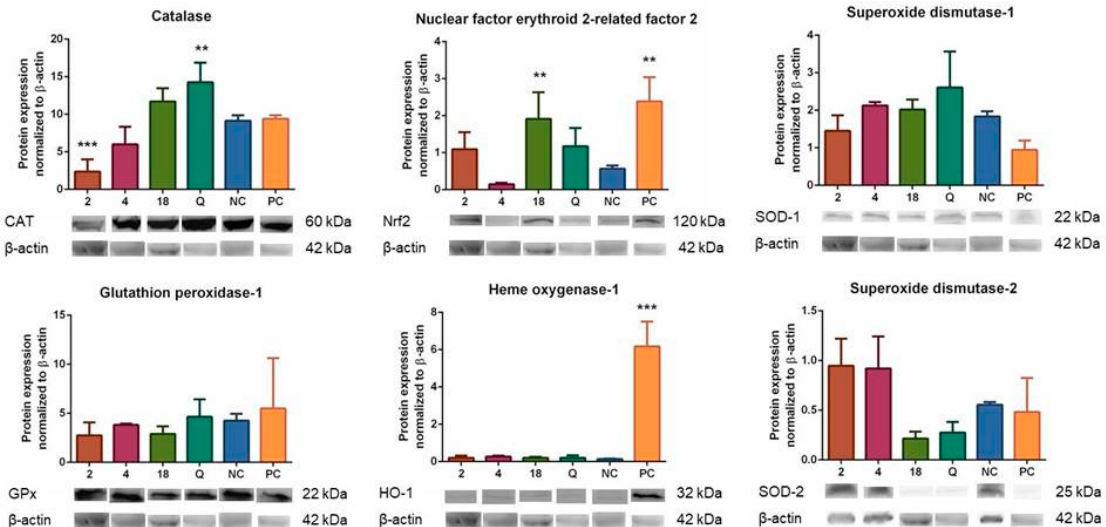
Figure 6. E ff ects of compounds 2 , 4 , and 18 (at a concentration of 2 µ M) on the levels of selected antioxidant enzymes CAT, GPx, HO-1, and SOD-1 and -2, and on the expression of Nrf2 after 6 h of incubation. The THP-1-XBlue-CD14-MD2 cell model was used with quercetin as the standard (2 µ M), pyocyanin alone (100 µ M) as the positive control (PC), and the vehicle alone as the negative control (NC). ** = p < 0.01; *** = p < 0.001; and **** = p < 0.0001.